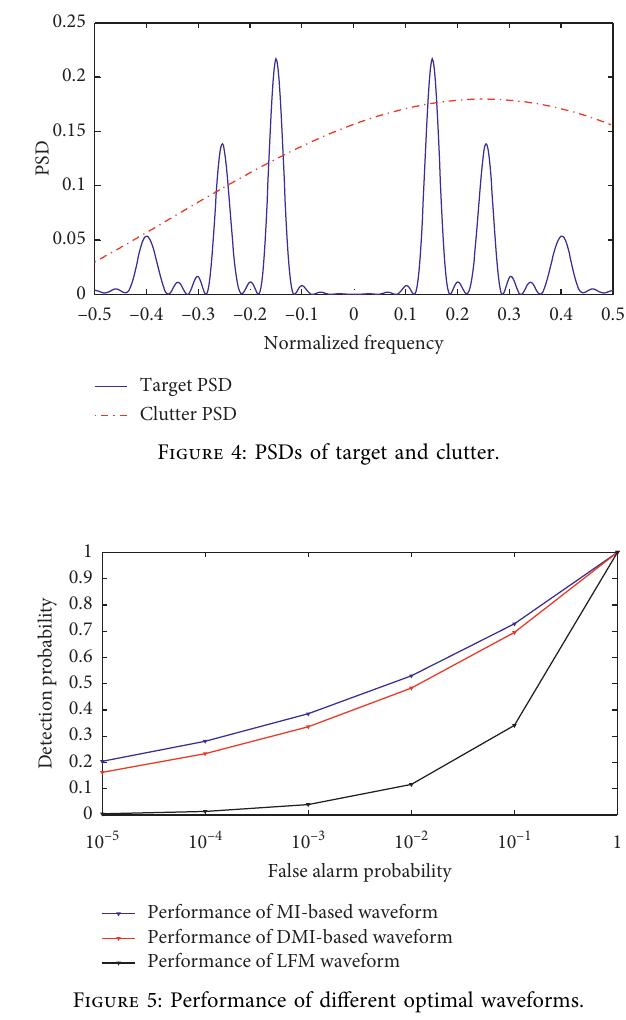
Figure 3: The flow chart of algorithm.